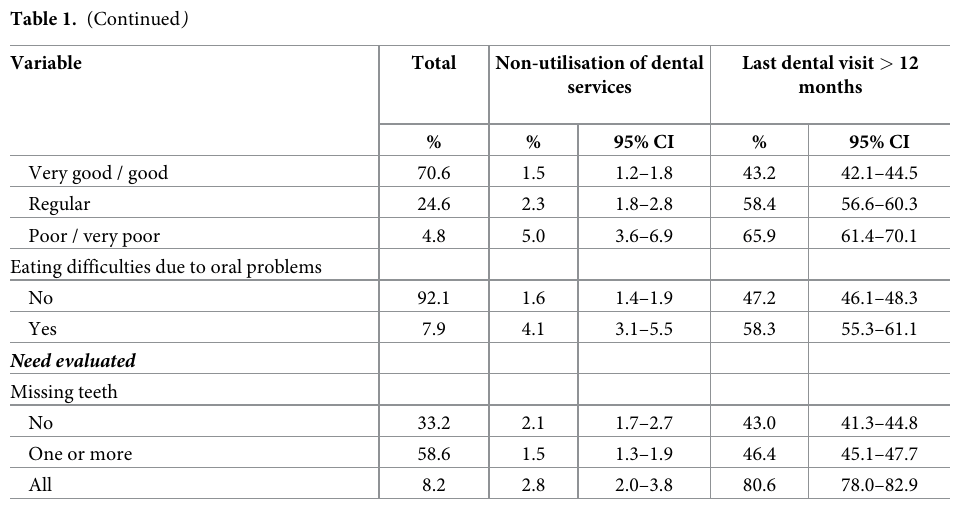
Table 2. Rotated component matrix presenting factor loadings for the contextual variables included in the factor analysis at city-level. Variables